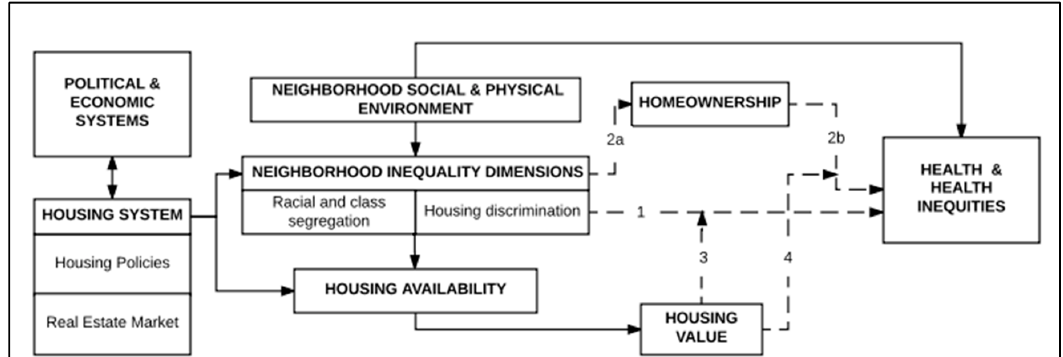
Figure 1. Conceptual model exploring the systemic effects on the relation between homeownership, health and health inequities. The dotted arrows and corresponding numbers represent the pathways examined in the study. Adapted from Novoa et al. 2014 [44]; Saegert et al. 2011 [45]. The dotted arrows represent pathways examined in this study. While effects of political and